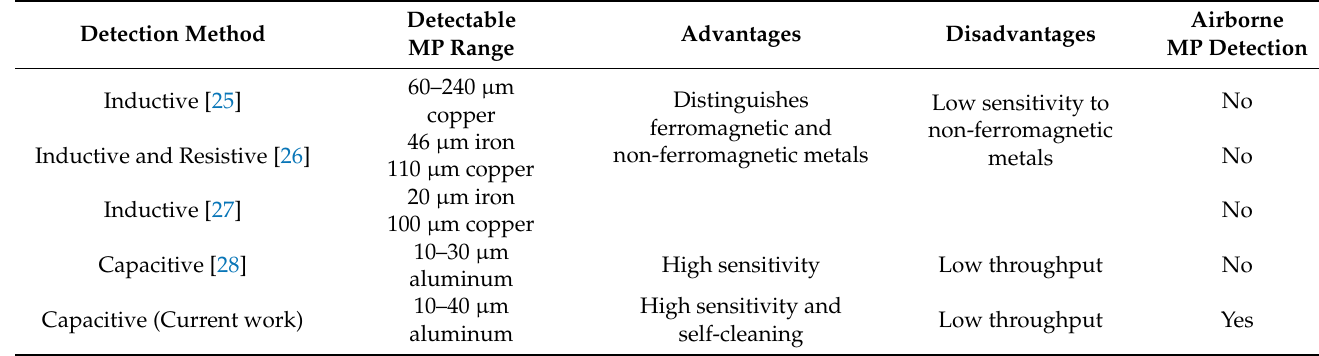
Table 2. Comparison of current work with other MEMS-compatible MP detection sensors recently developed. Detection